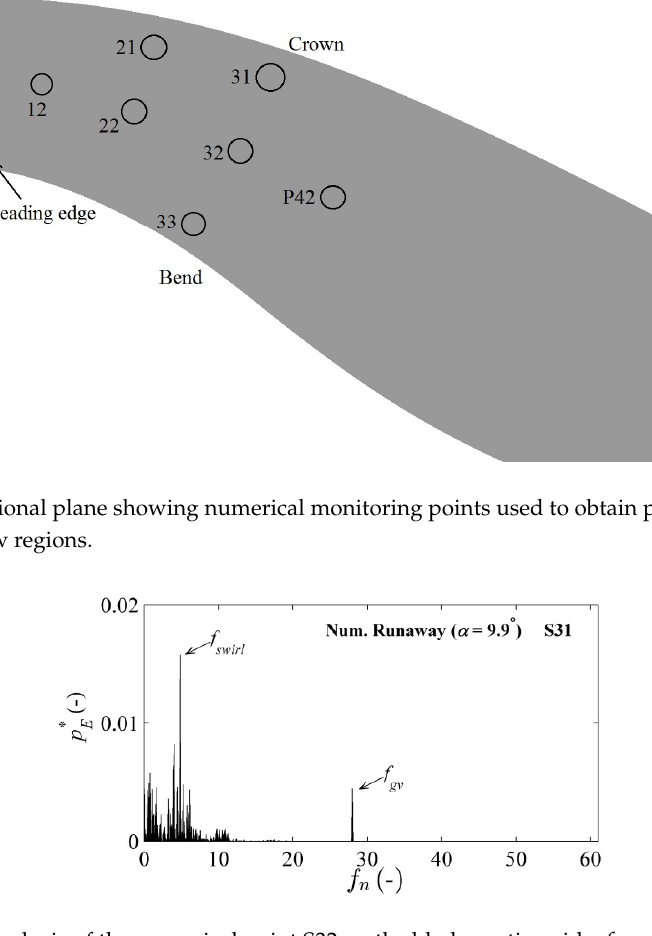
Figure 20. Time ‐ dependent variation in the swirl frequency 4.8 ∙ n R at S31 at the runaway operating condition ( = 9.9°); f gv denotes the guide vane passing frequency (28), f swirl denotes the swirl frequency at S31.